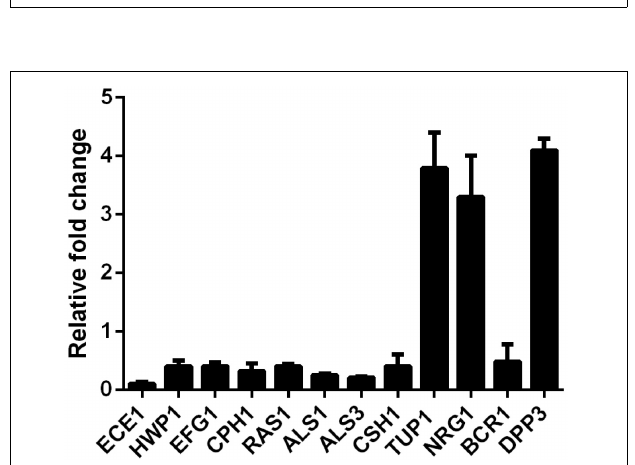
FIGURE 3 | Effects of different concentrations of SK on the cell surface hydrophobicity (CSH) of C. albicans biofilms. CSH was estimated by the water-hydrocarbon two-phase assay. Data are expressed as the mean ± standard deviation of the independent assays in triplicate. ∗ P < 0.05; ∗∗ P < 0.01 as compared to the SK-free group.